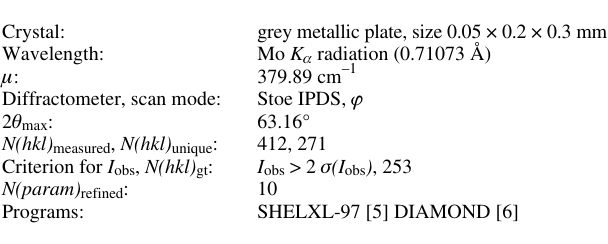
Table 1. Data collection and